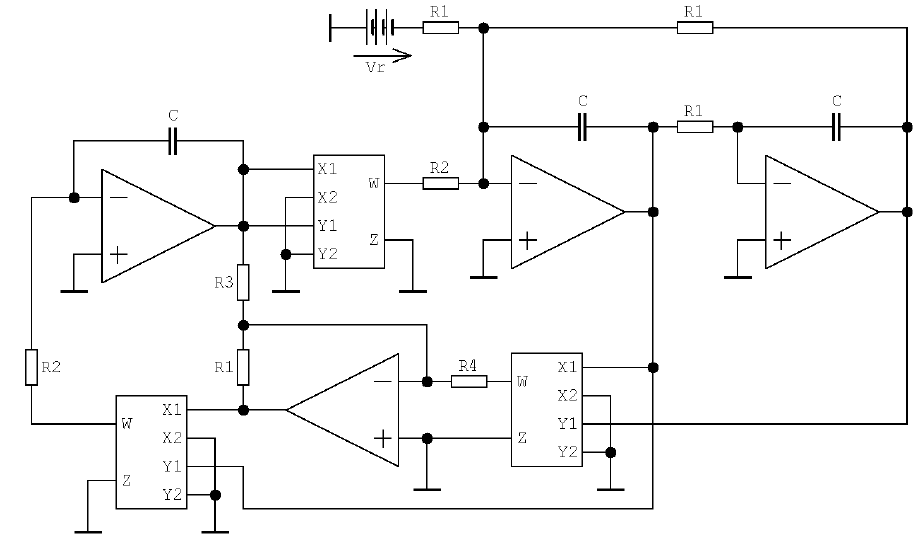
Figure 6. Circuitry realization of the discovered chaotic dynamical system, voltage-mode concept.